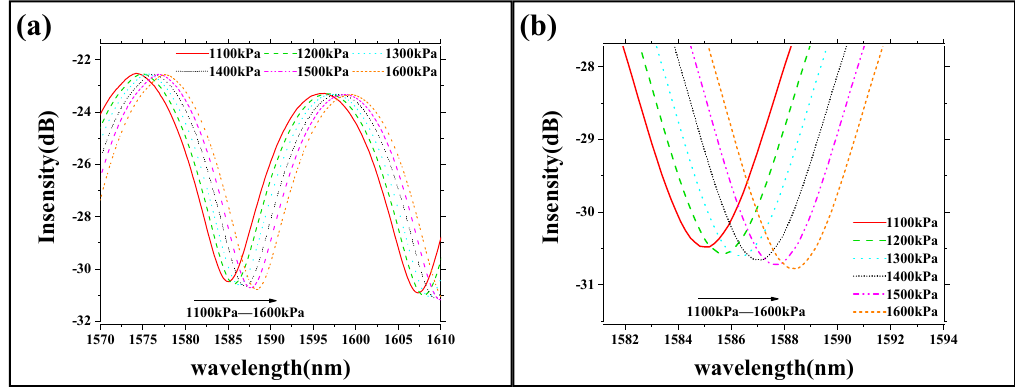
Figure 11. ( a ) The movement of the interference spectrum under pressure change of 1000~1600 kPa; ( b ) local amplification of interference peak.